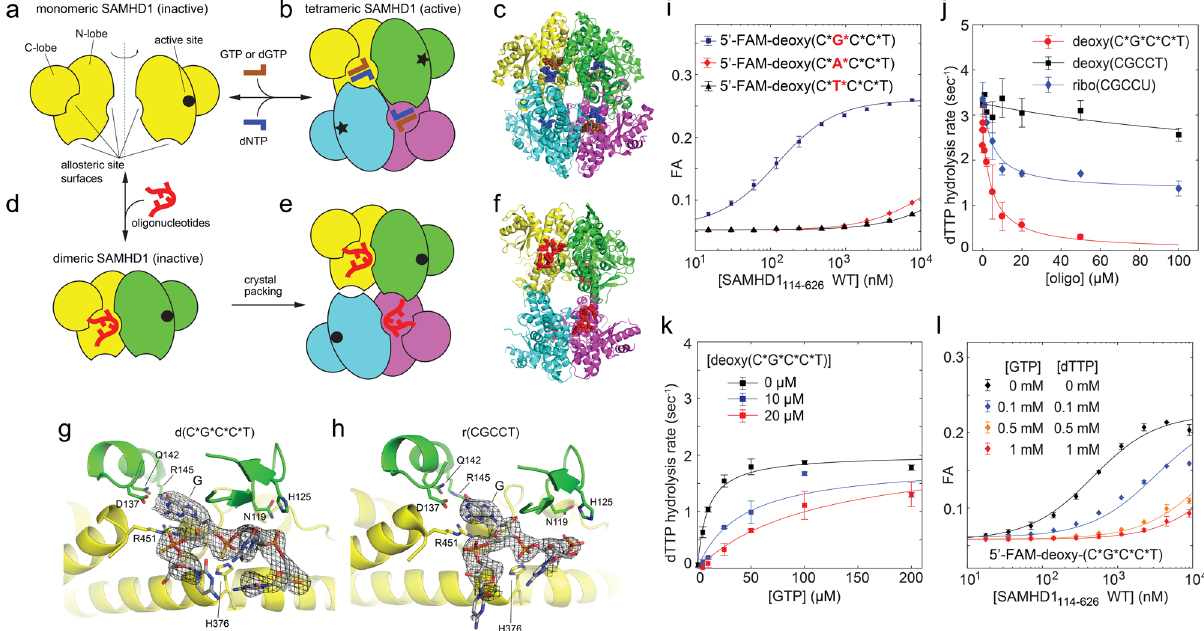
Fig. 2 Crystal structures of SAMHD1:oligonucleotide complexes reveal that oligonucleotides compete with nucleotide triphosphates for binding to the allosteric sites. a Without allosteric ligands, the HD-domain construct of SAMHD1 is monomeric in solution. b In the presence of nucleotide triphosphates, it assembles into a tetramer with almost perfect 222-point symmetry. c Backbone cartoon of the GTP/dCTP-bound SAMHD1 structure 18 (PDB: 4TNP). d In the presence of oligonucleotides SAMHD1 dimerizes. e Packing of two SAMHD1 dimers in the asymmetric unit of the oligonucleotide-bound crystals lacks 222-point symmetry. f Backbone cartoon of the d(C*G*C*C*T)-bound SAMHD1 structure (PDB: 6U6X). Electron-density maps of the d(C*G*C*C*T) ( g ) and r(CGCCU) ( h ) oligonucleotides bound in the allosteric sites of SAMHD1 (PDB: 6U6X and PDB: 6U6X, respectively). The mesh shows the composite 2mFo-DFc omit map contoured at 1.5 σ . i Binding of the G nucleobase in the guanine-recognition pocket of A1 is a determinant of the oligonucleotide- binding af fi nity ( n = 2 independent experiments). j Phosphorothioation enhances dNTPase inhibition by oligonucleotide binding. dTTP hydrolysis rates were measured at [GTP] = 50 μ M and [dTTP] = 1 mM ( n = 2 independent experiments). k EC 50 GTP but not k cat of the dNTPase activity is affected by